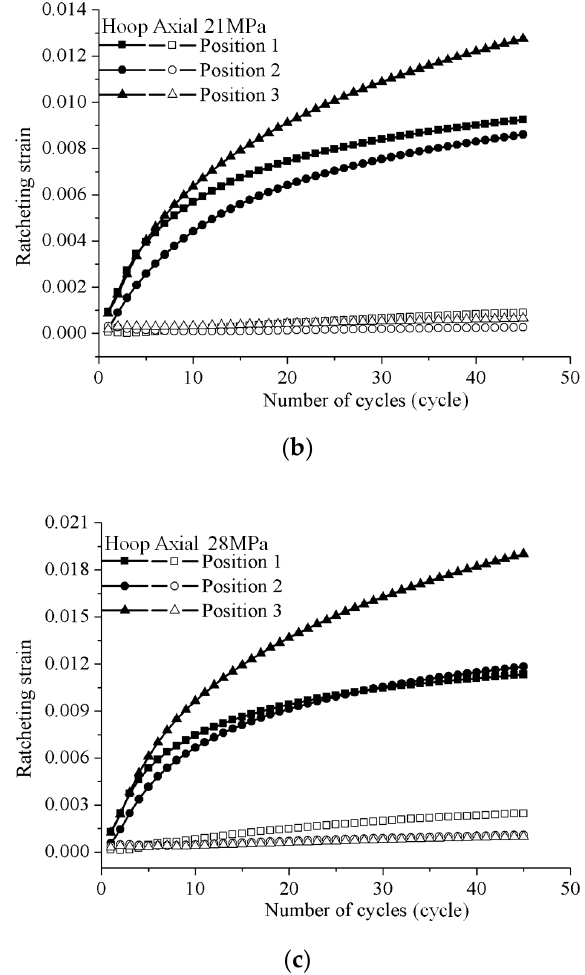
Figure 9. Ratcheting response under different internal pressures: ( a ) 10 MPa, ( b ) 21 MPa, and ( c ) 28 MPa.